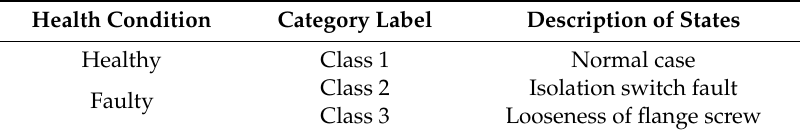
Figure 1. Experiment and mechanical fault simulation: ( a ) experiment and field testing; ( b ) mechanical fault simulation. Table 1. Summary of states of gas-insulated switchgear (GIS) considered in this study.